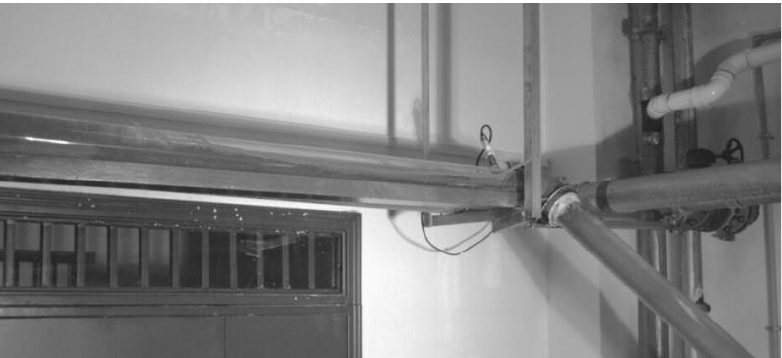
Figure 6. Incomplete interruption at Point 2 at the knee.